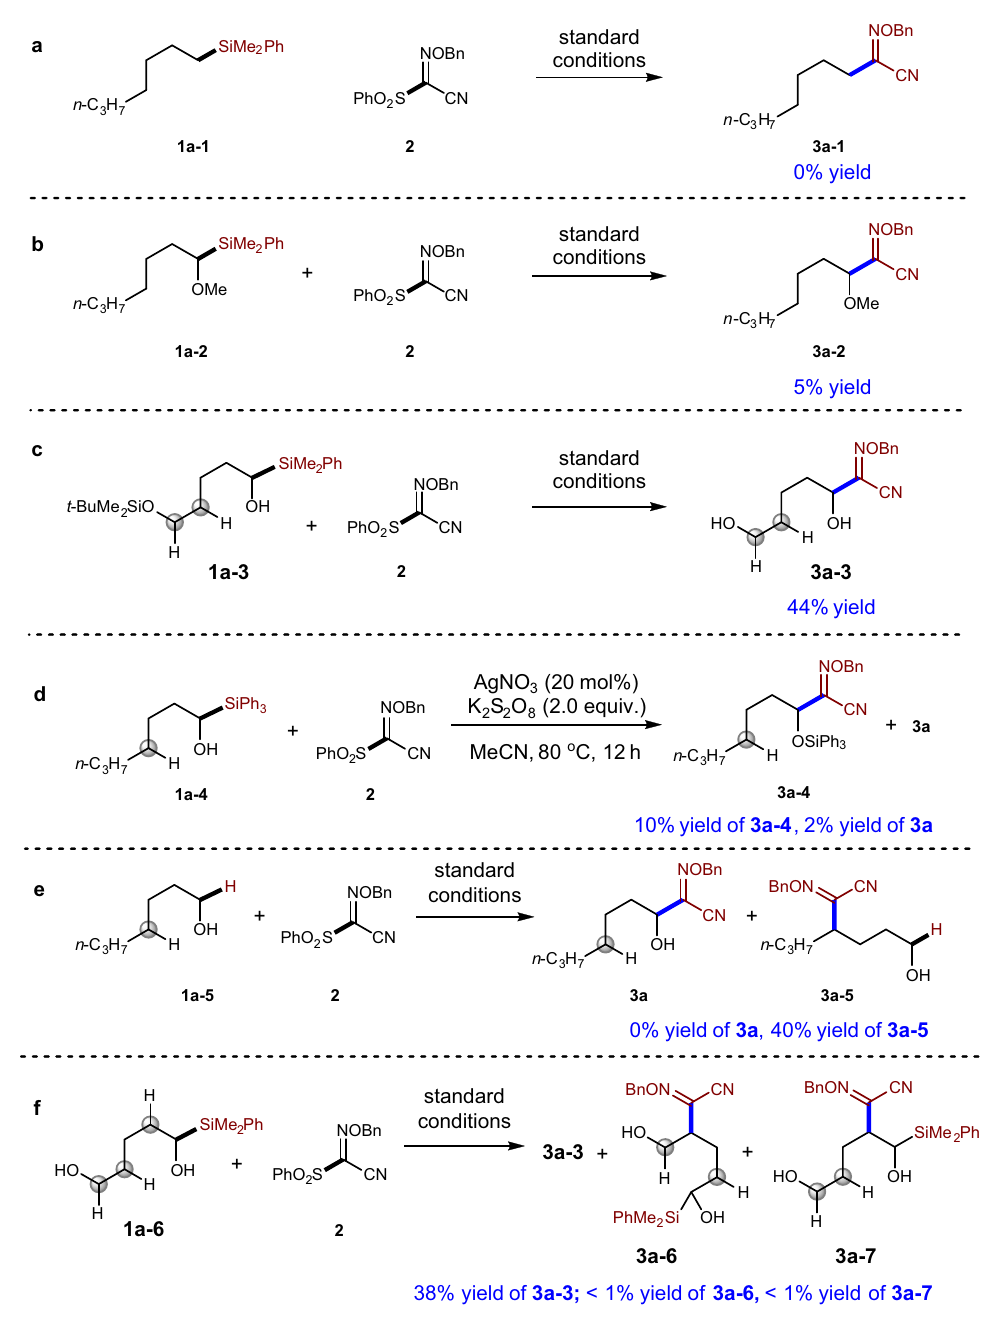
Fig. 4 Mechanistic studies. a Failure of the reaction with heptyldimethyl(phenyl)silane 1a-1 indictates the importance of OH group in the success of the reactions. b Failure of the reaction of protected α -silyl alcohol 1a-2 indicates that direct oxidative cleavage of C – Si bond is less likely. c Reaction 1a-3 shows that silyl ether group could be hydrolyzed under the reaction conditions. d Reaction of α -triphenylsilyl alcohol 1a-4 under conditions without H 2 O could afford non-desilylated product 3a-4 . e The reaction of non-silylated alcohol 1a-5 indeed afforded 1,5-HAT product 3a-5 without the formation of ɑ - functionalization product 3a . f Remote OH group in 1a-6 can be